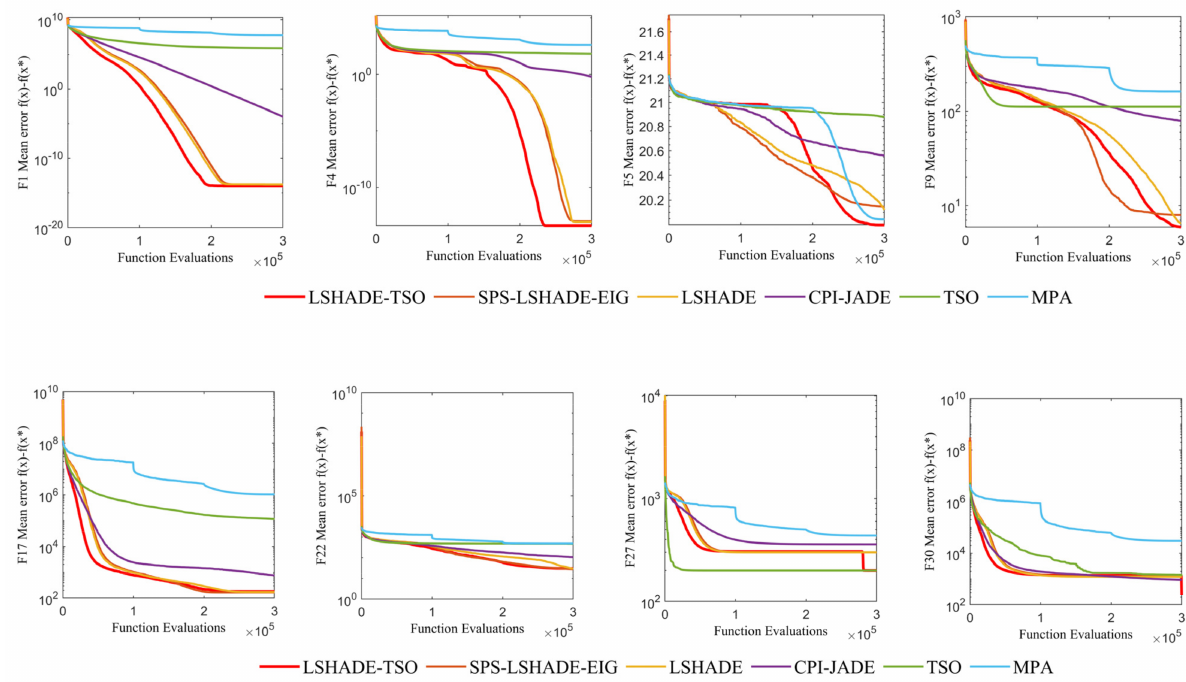
Figure 5. Convergence curves of the four algorithms. * represents the minimum value of the test function.